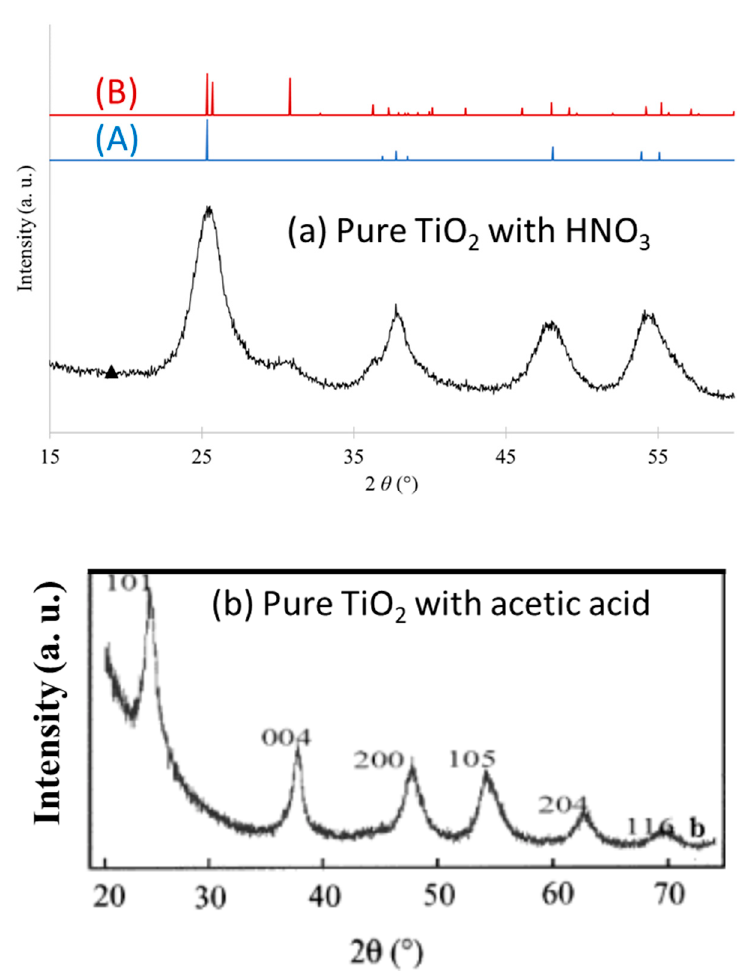
Figure 5. XRD patterns of pure TiO 2 material obtained with ( a ) HNO 3 , where A stands for anatase phase and B for brookite phase from [142] (reproduced with permission from J. G. Mahy et al., AIMS Materials Science; published by AIMS Press, 2018, open access); and ( b ) acetic acid peptizing agents, from [133] (reproduced with permission from J. L. Gole et al., The Journal of Physical Chemistry B; published by The American Chemical Society,